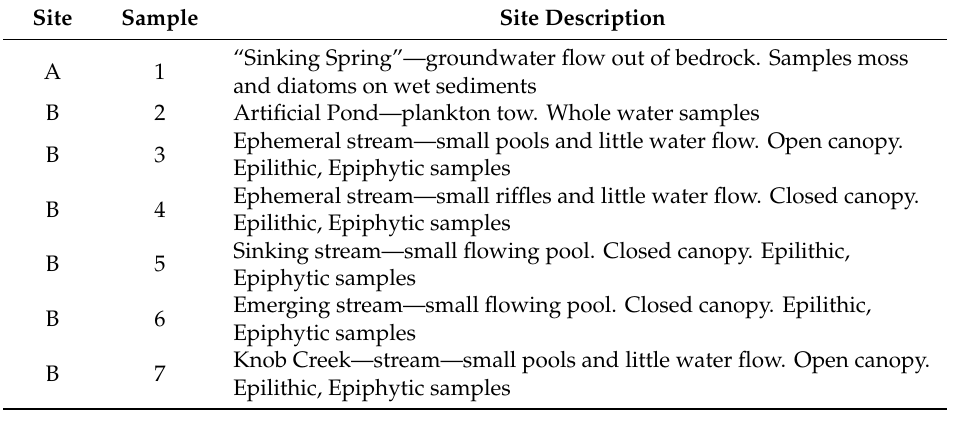
Figure 3. Location of the sampling site A ( a ) and site B ( b ) for samples #1 to #7. Table 1. Site (#1–7) and samples descriptions from the Abraham Lincoln Birthplace National Historical Park in Kentucky, USA.